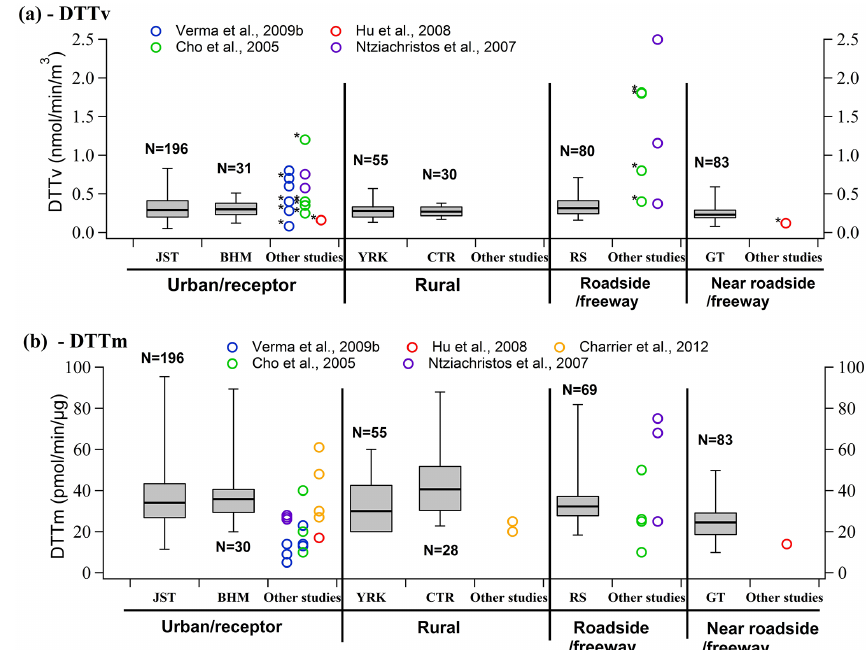
Figure 8. Distribution of water-soluble volume-normalized (a) and mass-normalized (b) DTT activity (oxidative potential) of ambient PM 2 . 5 in our study compared with other studies. Data from this study are expressed as median, maximal, minimal, and percentile 25 and 75. Roadside/freeway – sampling sites are located adjacent to road/highway; near roadside/freeway – sampling sites are further away but less than 1km from road/freeway. ∗ – numbers not presented in the paper, thus estimated from